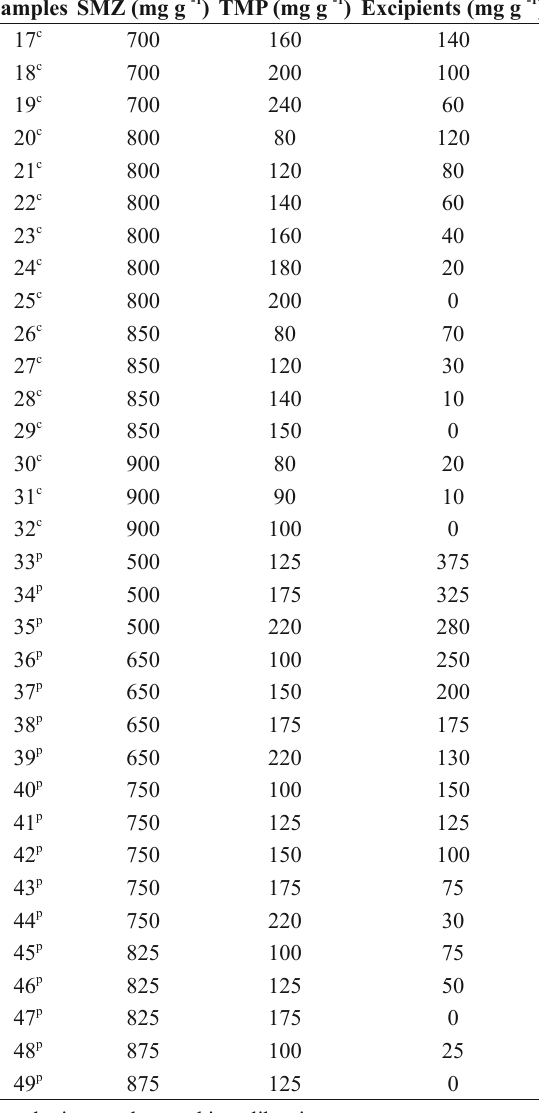
C synthetic samples used in calibration set. p synthetic samples used in prediction